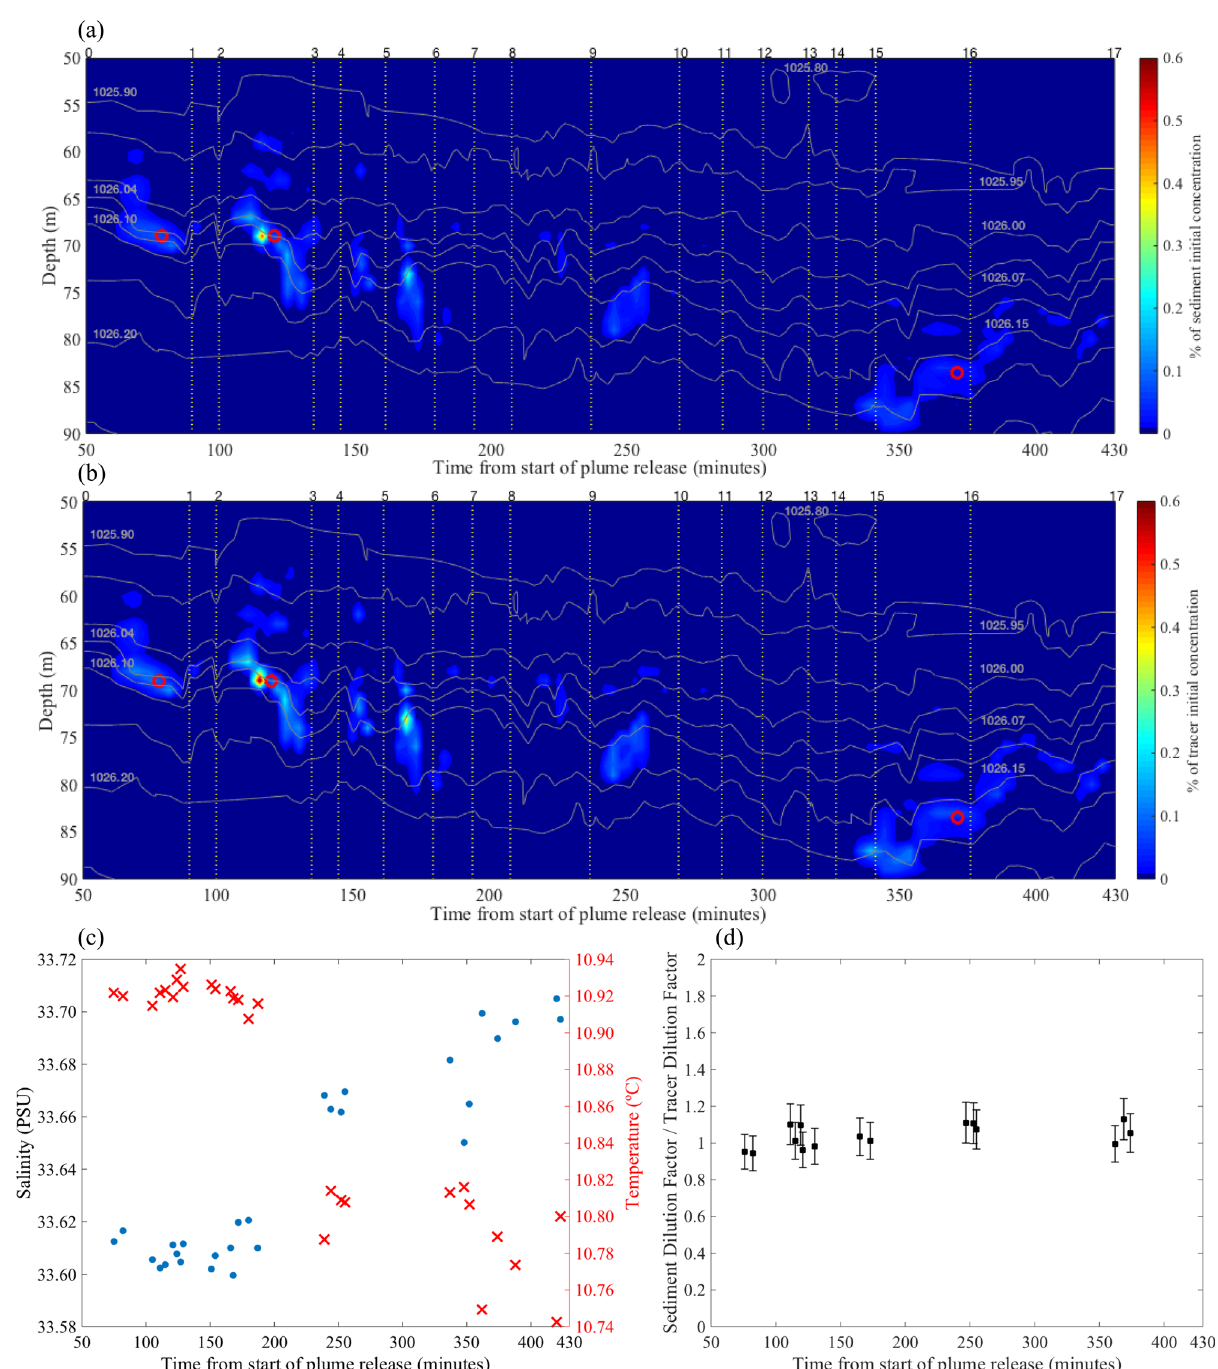
Fig. 5 Tow-yo observations of the CCFZ sediment ambient plume. a Time series of inverse dilution factor (as a percentage of initial discharge concentration) for CCFZ sediment and b dye tracer. The red circles indicate samples for which data is presented in Fig. 6. The vertical dotted lines indicate the start/end of each transect and the numbering from 0 to 17 at the top corresponds to the numbered locations indicated in Fig. 4. c Evolution of the CCFZ sediment ambient plume temperature (red crosses) and salinity (blue dots) over time. d Evolution of the ratio between the ambient plume sediment and tracer dilution factors. Error bars represent the standard